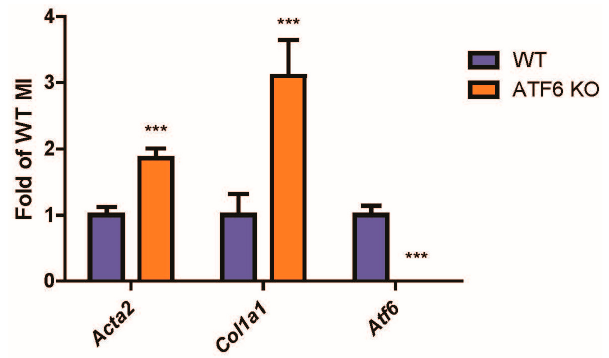
Figure 1. Markers of fibroblast activation in activating transcription factor-6 α (ATF6) knockout (KO) hearts of mice subjected to myocardial infarction (MI) surgery. Wild-type (WT) and ATF6 KO mice were subjected to permanent occlusion MI for one week. mRNA from infarcted regions in the hearts was then examined by qRT-PCR for genes indicative of cardiac fibroblast (CF) activation, α smooth muscle actin ( α SMA) ( Acta2 ) and collagen ( Col1a1 ), as well as ATF6 ( Atf6 ). *** p ≤ 0.001 significant difference from WT by Student’s t-test.